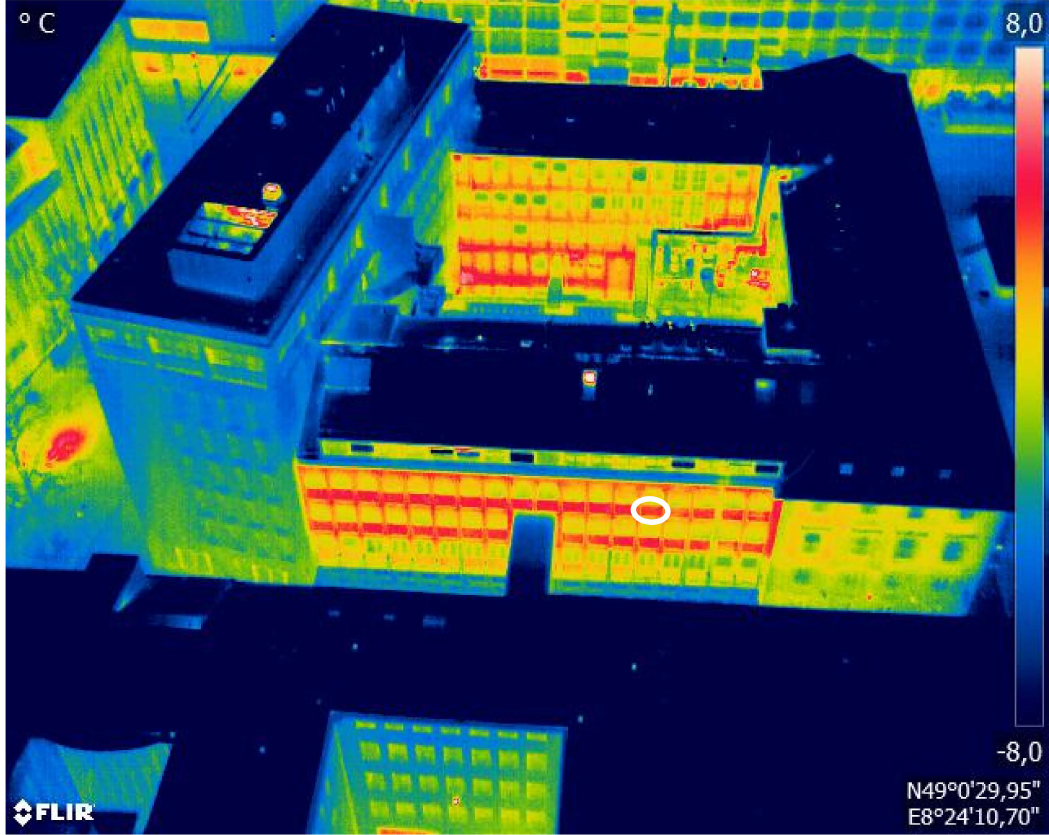
Figure A11. Example: thermal bridge of a window